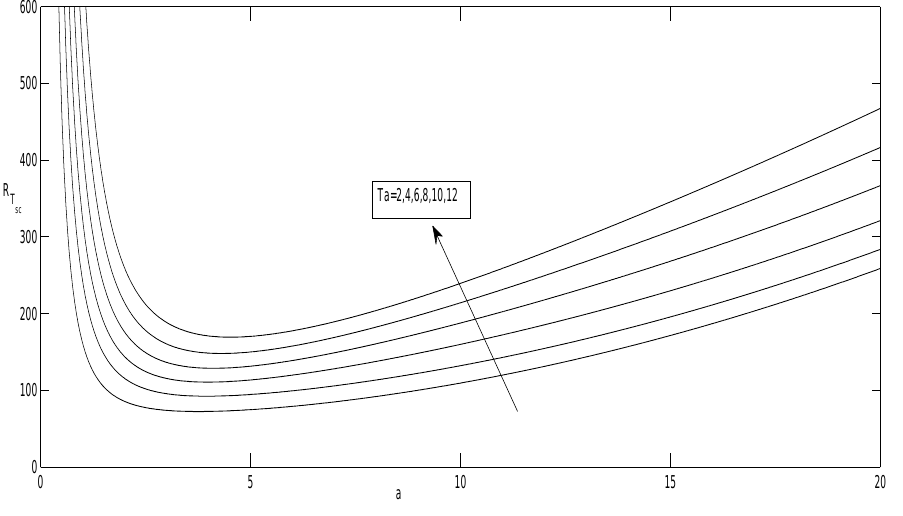
Figure 2. Neutral curves for the different values of Ta and for the fixed values of γ = 0.5, η = 0.2, κ r = 1, R C = 50, and S = 0.5 for the stationary